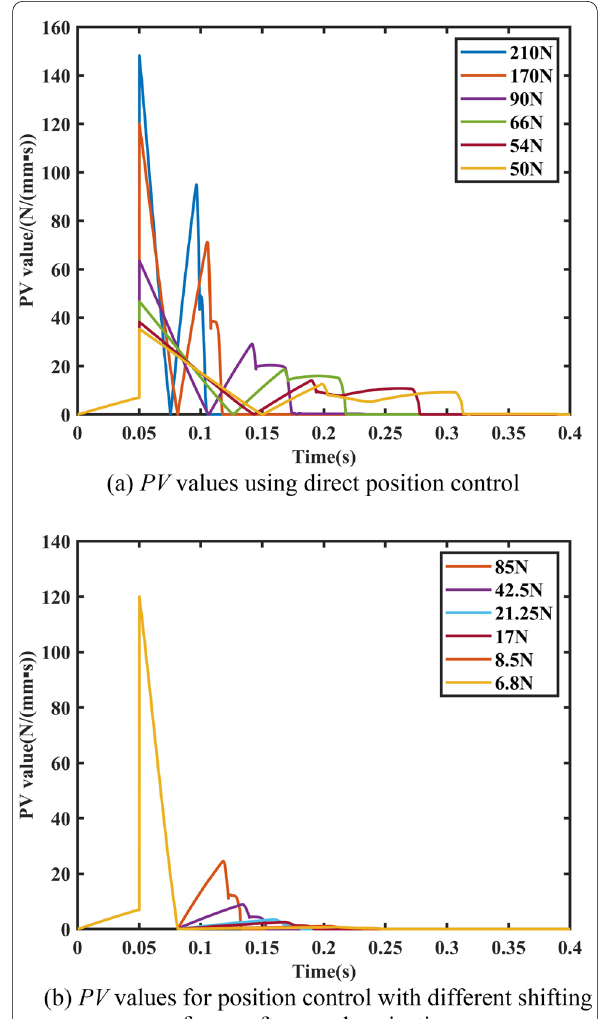
Figure 7 Synchronizer shifting PV value for different shifting modes